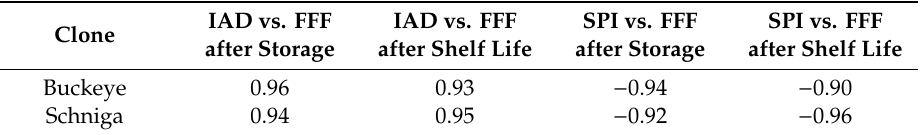
Table 1. Correlation (Pearson r) between mean IAD or starch pattern index (SPI) assessed at harvest and mean firmness (FFF) after storage (0 and 7 d shelf life) of two clones of cv. ‘Gala’. Correlations are significant at p < 0.005 level (Tukey HSD, p < 0.005).